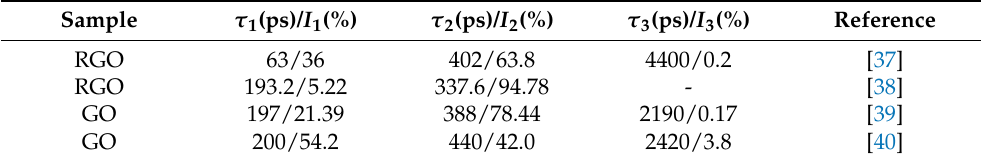
Table 1. PALS parameters of RGO and